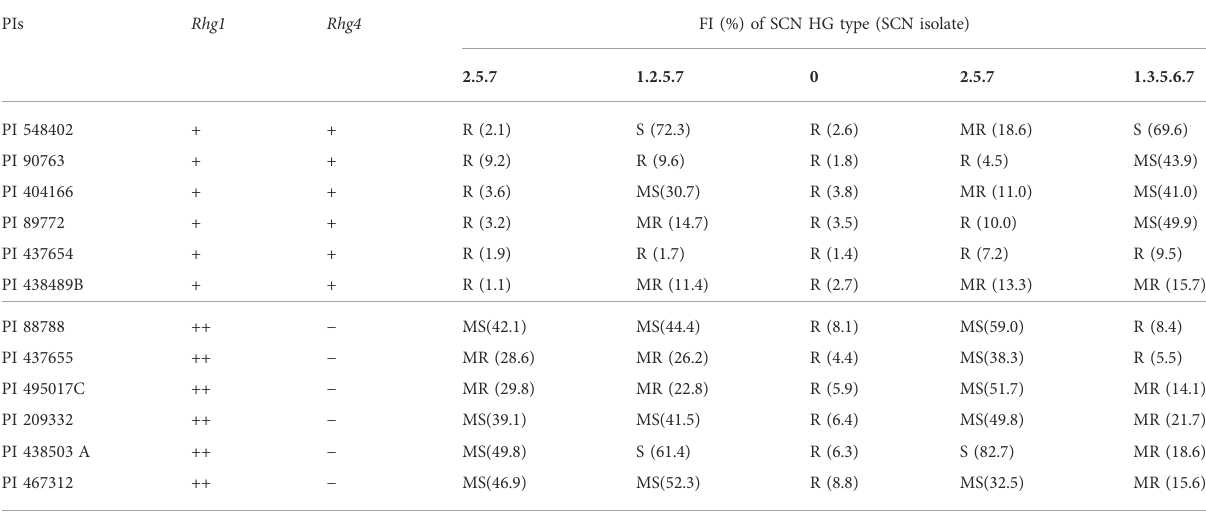
TABLE 1 Bulks of Peking- and PI 88788-type sources of resistance to soybean cyst nematode (SCN). PIs Rhg1 Rhg4